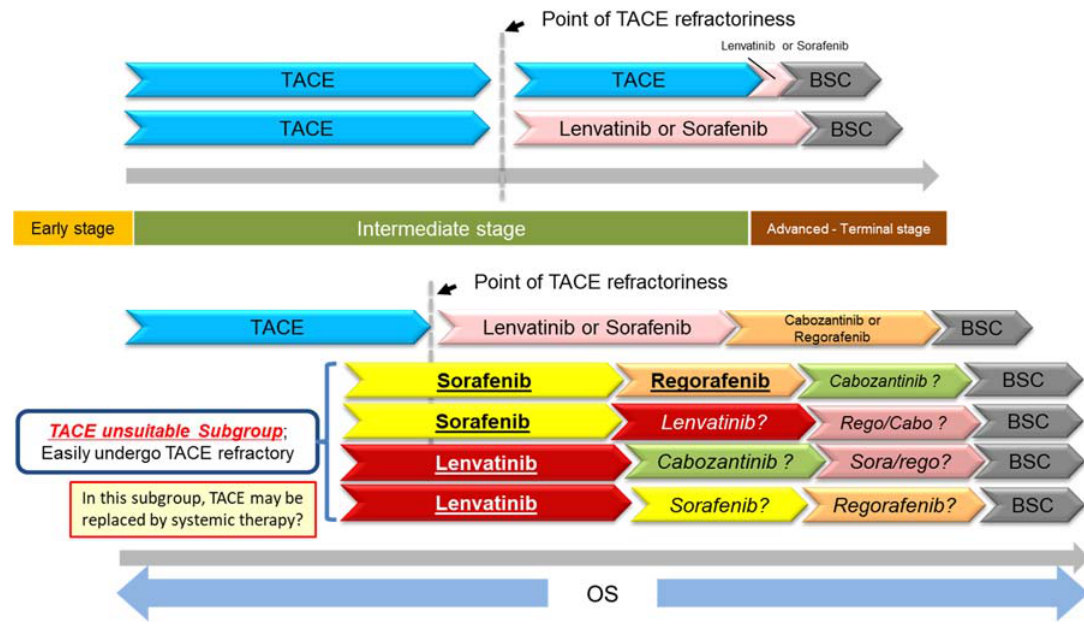
Figure 1. New treatment landscape in HCC. BSC: best supportive care.